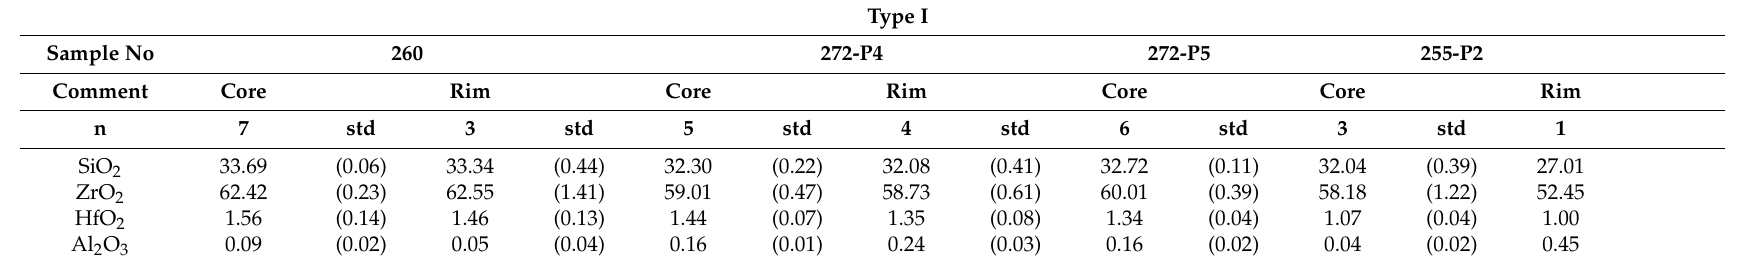
Table A2. EPMA analysis. Zircon in the Khaldzan Burgedei complex. Type